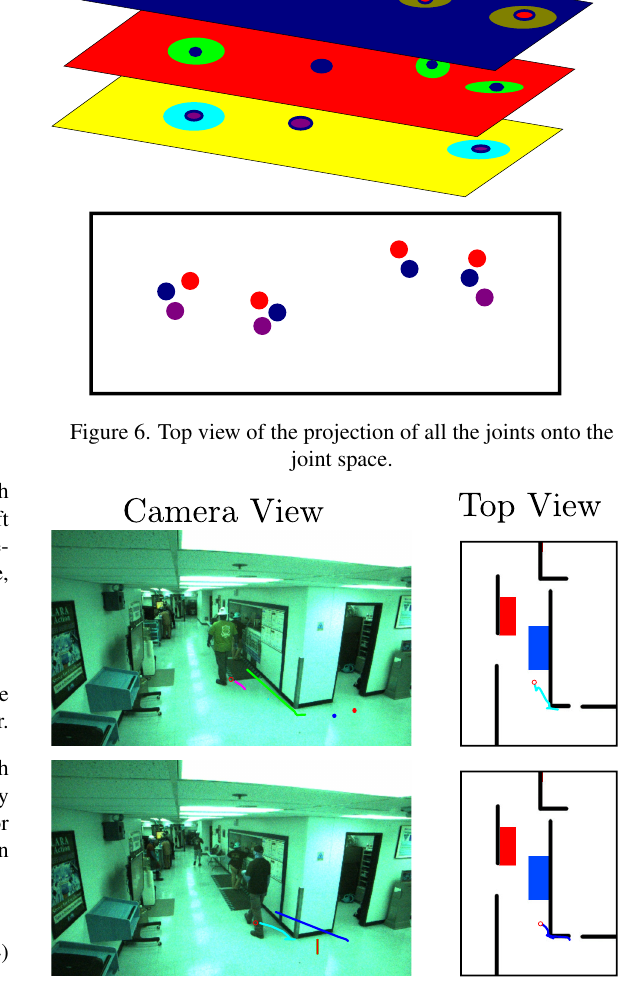
Figure 7. Only Ankle: Tracking in the image space (left images) is very unstable, while tracking on the anthropometric planes (right images) does not change the identity of the worker. Ankle For this experiment, we use only the detected ankles of workers and track them once in the image space, and simultaneously in the joint space. A constant velocity Kalman Filter with 4 inputs (cid:20) x (cid:21) is used for tracking in both spaces. Fig. (7) demonstrates ˙ x how unstable tracking in the image space is. On the other hand, since transforming the trajectory of ankles onto the joint space is more linear, the same tracking method with the same parameters significantly performs better. In the image space, we observe 4 and 3 identity changes in the top and bottom images, respectively. While no change of identity occurs in the joint space. Upper Body